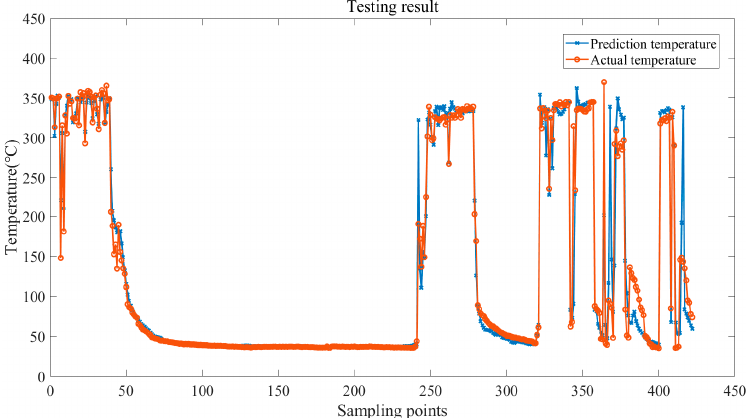
Figure 9. Model prediction outcomes.